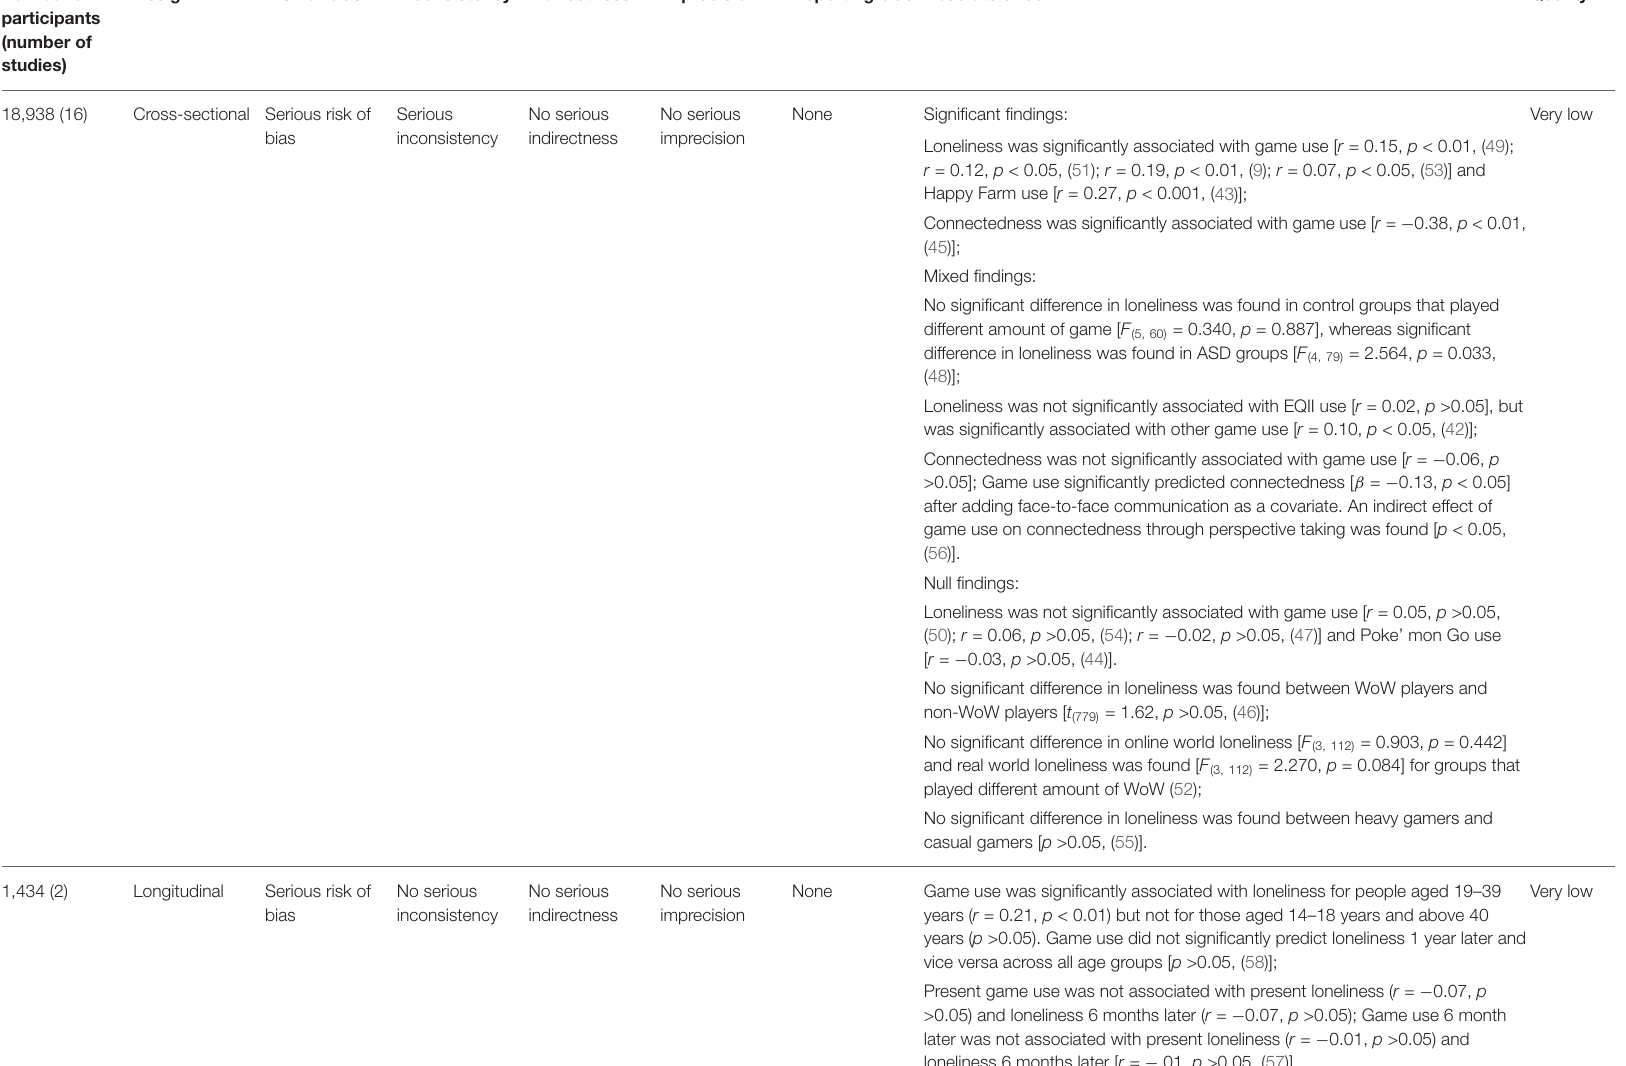
TABLE 3 | Quality of